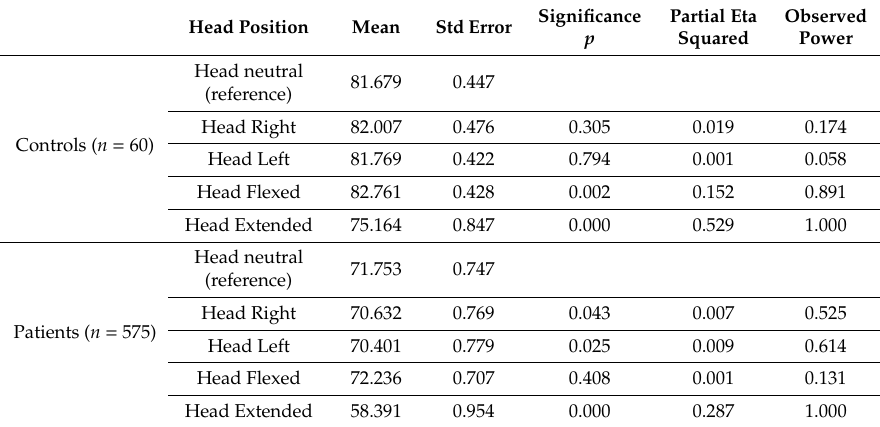
Table 3. Stability score (mean and SEM) for the di ff erent head positions for the two groups (healthy controls and patients). The repeated measures GLM results of the di ff erences from the head neutral reference position for each group are also included.